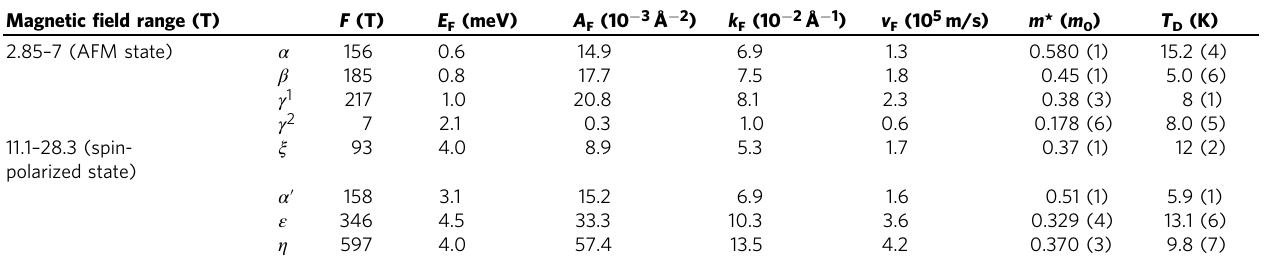
Table 1 Parameters derived from quantum oscillations in different magnetic fi eld range for EuAs 3 . Magnetic fi eld range